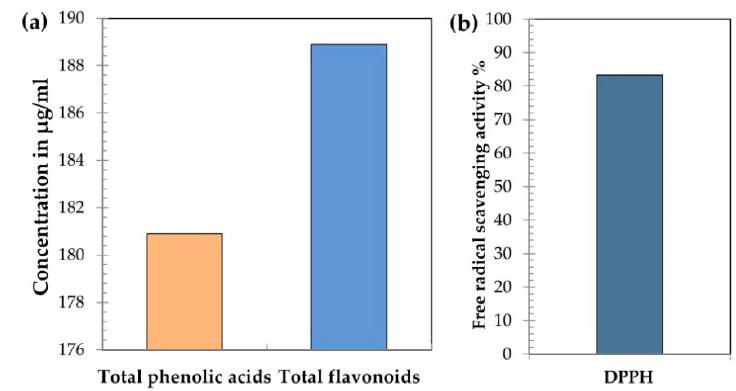
Figure 1. Polyphenols content measured by HPLC ( a ) and free radical scavenging activity as DPPH% ( b ) of propolis supplemented to hen diet.